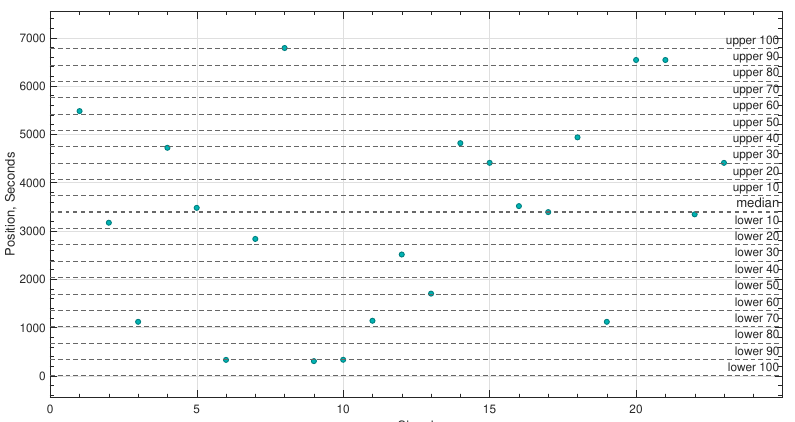
Figure 4. This figure shows an example of a logical flase classification process used to identify abnormal activity. The y-values represent the position of the maximum PLV values in seconds and the boundaries represent the constraint ρ . In this case, no abnormal activity is